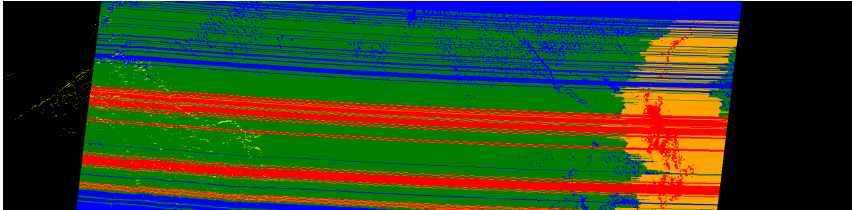
Figure 7. Map of the MISR L1B2 radiance quality data for Path 168, Orbit 2111, Block 110 and camera BA, in the red spectral band. This particular data channel is always available at the spatial resolution of 275m. The linear dimensions of the mapped area are identical to those indicated in Fig. 3. Color coding: black, edge pixels; yellow, area obscured by the local topography; blue, good data (RDQI=00); green, fair data (RDQI=01); gold, poor data (RDQI=10); and red, bad or missing data